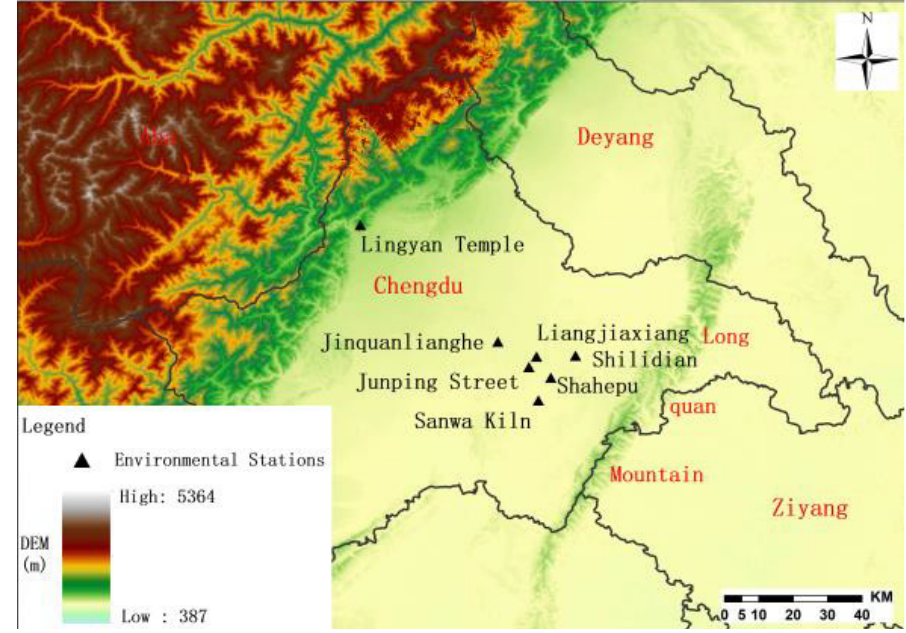
Figure 4. Map of the environmental monitoring stations in Chengdu.